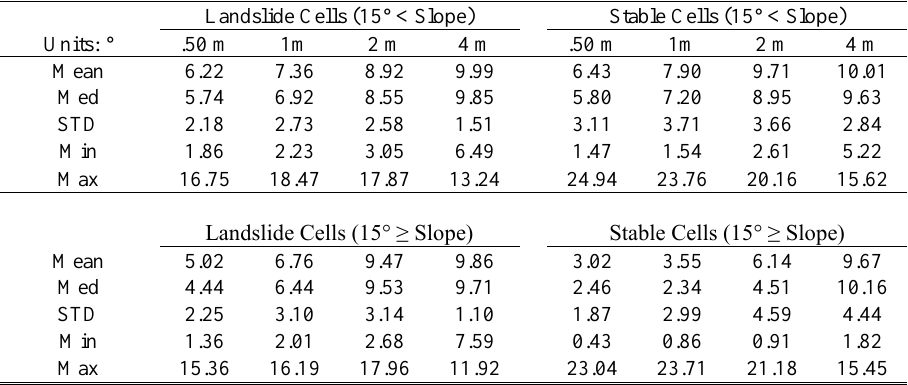
Table 8. Statistics of slope surface feature.